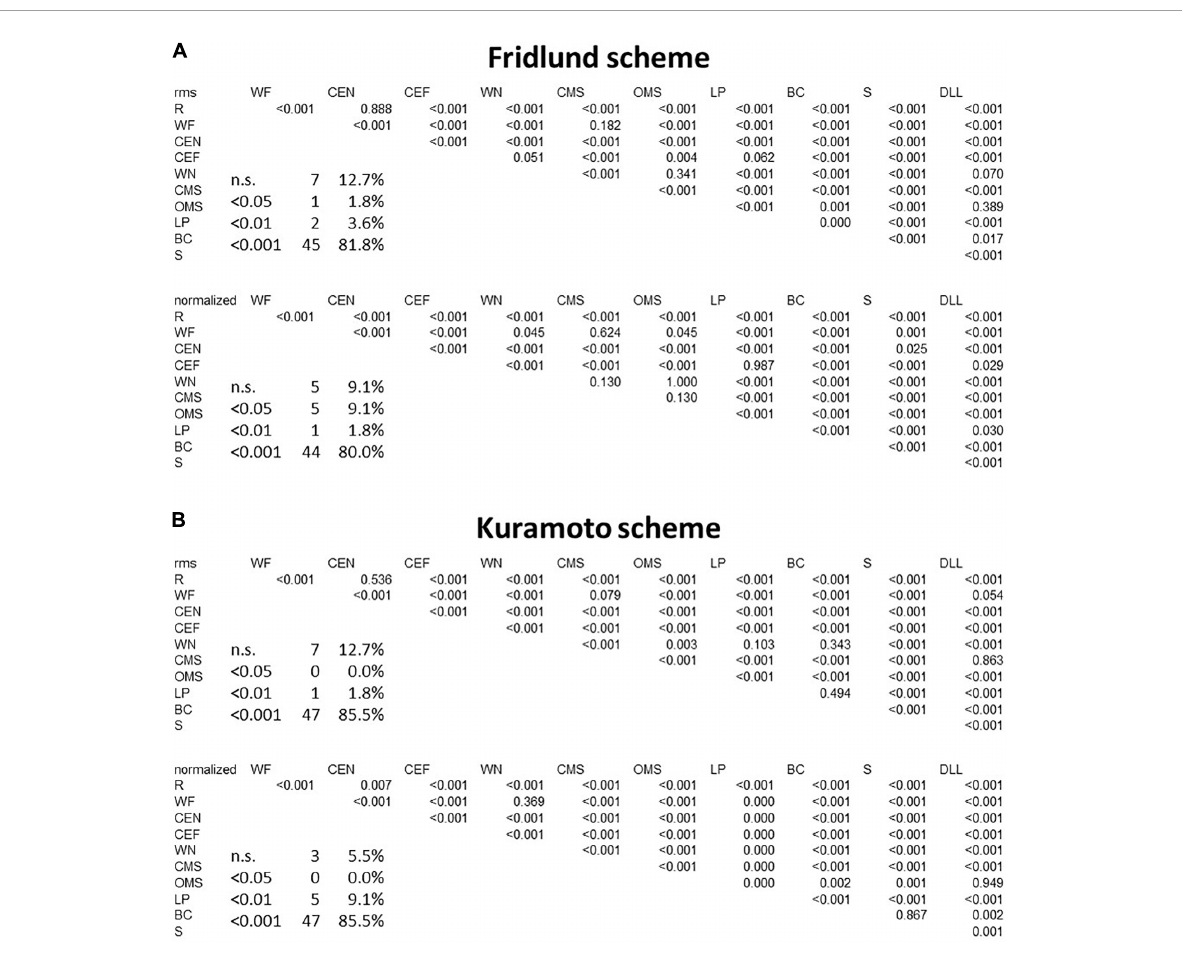
FIGURE4 Results of the between-movement comparisons by applying a linear mixed-effects model. (A) Fridlund scheme. (B) Kuramoto scheme. Upper row for both schemes: row data; lower row: normalized data. Significance levels are color-coded: p < 0.05: pink, p < 0.001: orange, p < 0.001: red. Also, the absolute numbers and relative numbers of non-significant and significant differences are provided. R, at rest; WF, wrinkling of the forehead; CEF, closing the eyes normally; CEF, closing the eyes forcefully; WN, wrinkling of the nose; CMS, closed mouth smiling; OMS, open mouth smiling; LP, lip puckering; BC, blowing-out the cheeks; S, snarling; DLL, depressing lower lip; n.s., not significant.